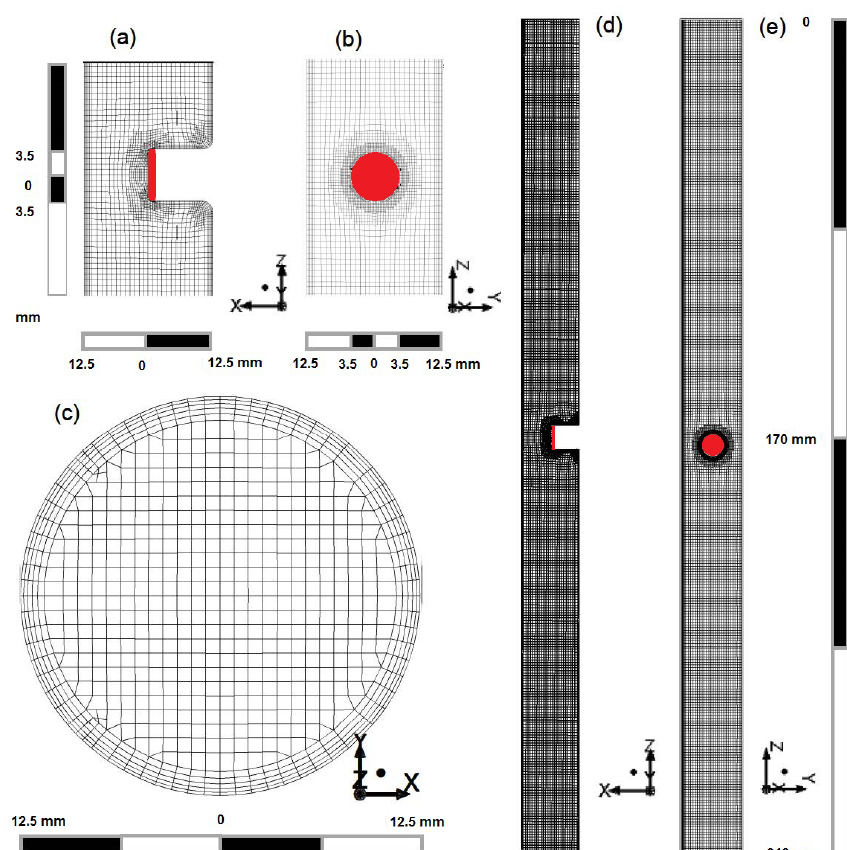
Figure 8. Cryogenic frost point hygrometer (CFH) intake tube mesh and geometry. The coordinate origin is located at the top centre of the intake tube. (a, b) Detailed views of the mirror holder on the y = 0 and x = 0 planes. (c) Intake tube cross section. (d, e) Intake tube on the y = 0 and x = 0 planes. Images used courtesy of ANSYS,